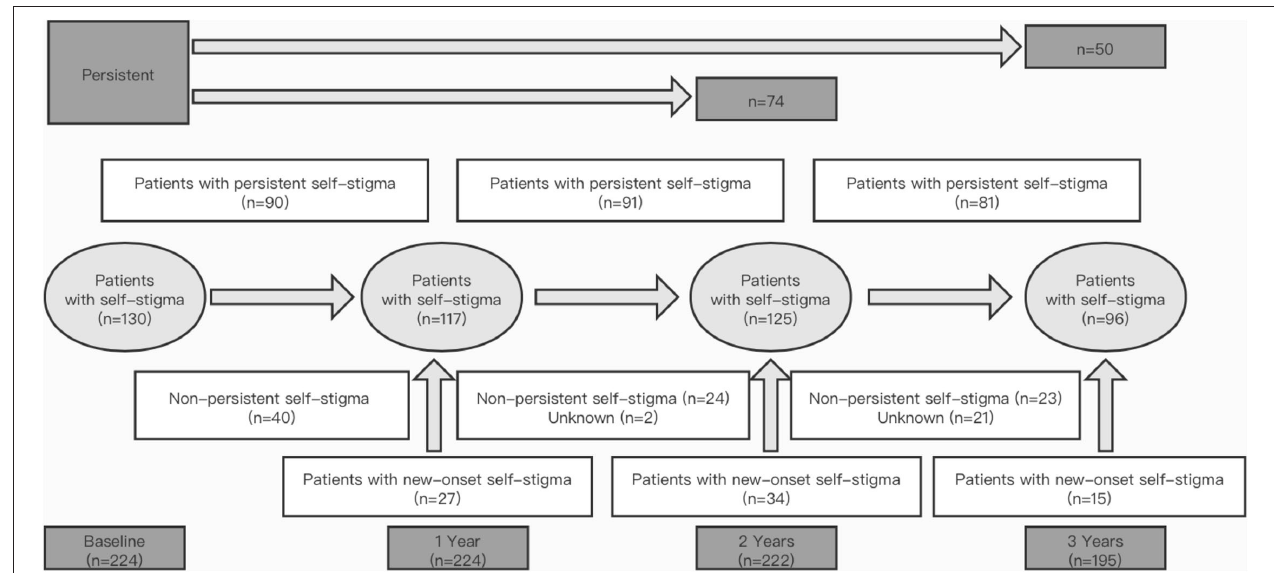
FIGURE 1 | Prevalence and persistence of self-stigma in patients with Parkinson’s disease (PD) over 3 years. “Patients with persistent self-stigma” means that self-stigma was persistent from one visit to the next; “Non-persistent self-stigma” means that self-stigma was present in a patient at the previous follow-up but absent at the next follow-up; “Patients with new-onset self-stigma” means that the self-stigma was absent in a patient with PD at the previous follow-up but present at the next